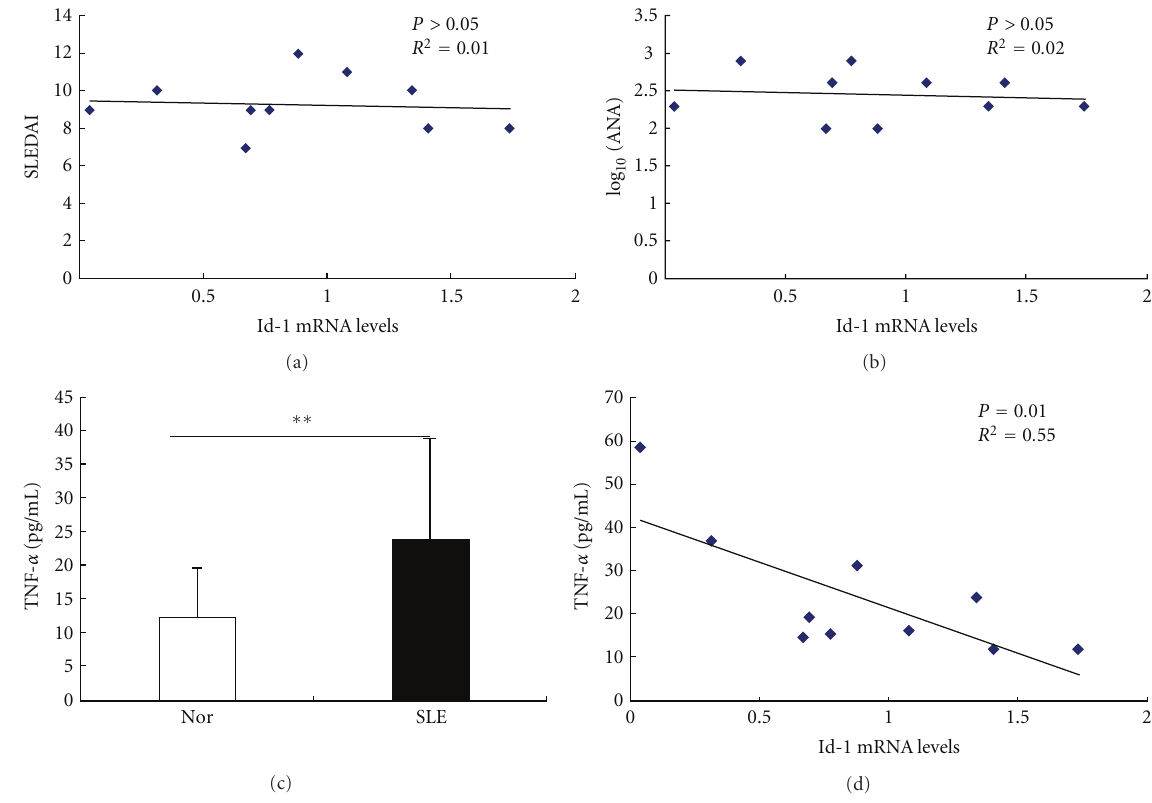
Figure 7: The correlation of Id-1 mRNA expression with serum TNF- α levels in SLE patients. (a, b) Id-1 mRNA level was not correlated with antinuclear antibodies (ANA) levels and SLE disease activity index (SLEDAI) score of SLE patients. (c) The serum level of TNF- α in SLE patients ( n = 10) were higher than that of normal controls ( n = 20). ∗∗ P < 0 . 01 versus normal controls by Student’s t -test. (d) Id-1 mRNA expression was reversely correlated with serum TNF- α level of SLE patients ( P = 0 . 01, r 2 = 0 . 55). SLE: systemic lupus erythematosus, Nor: normal